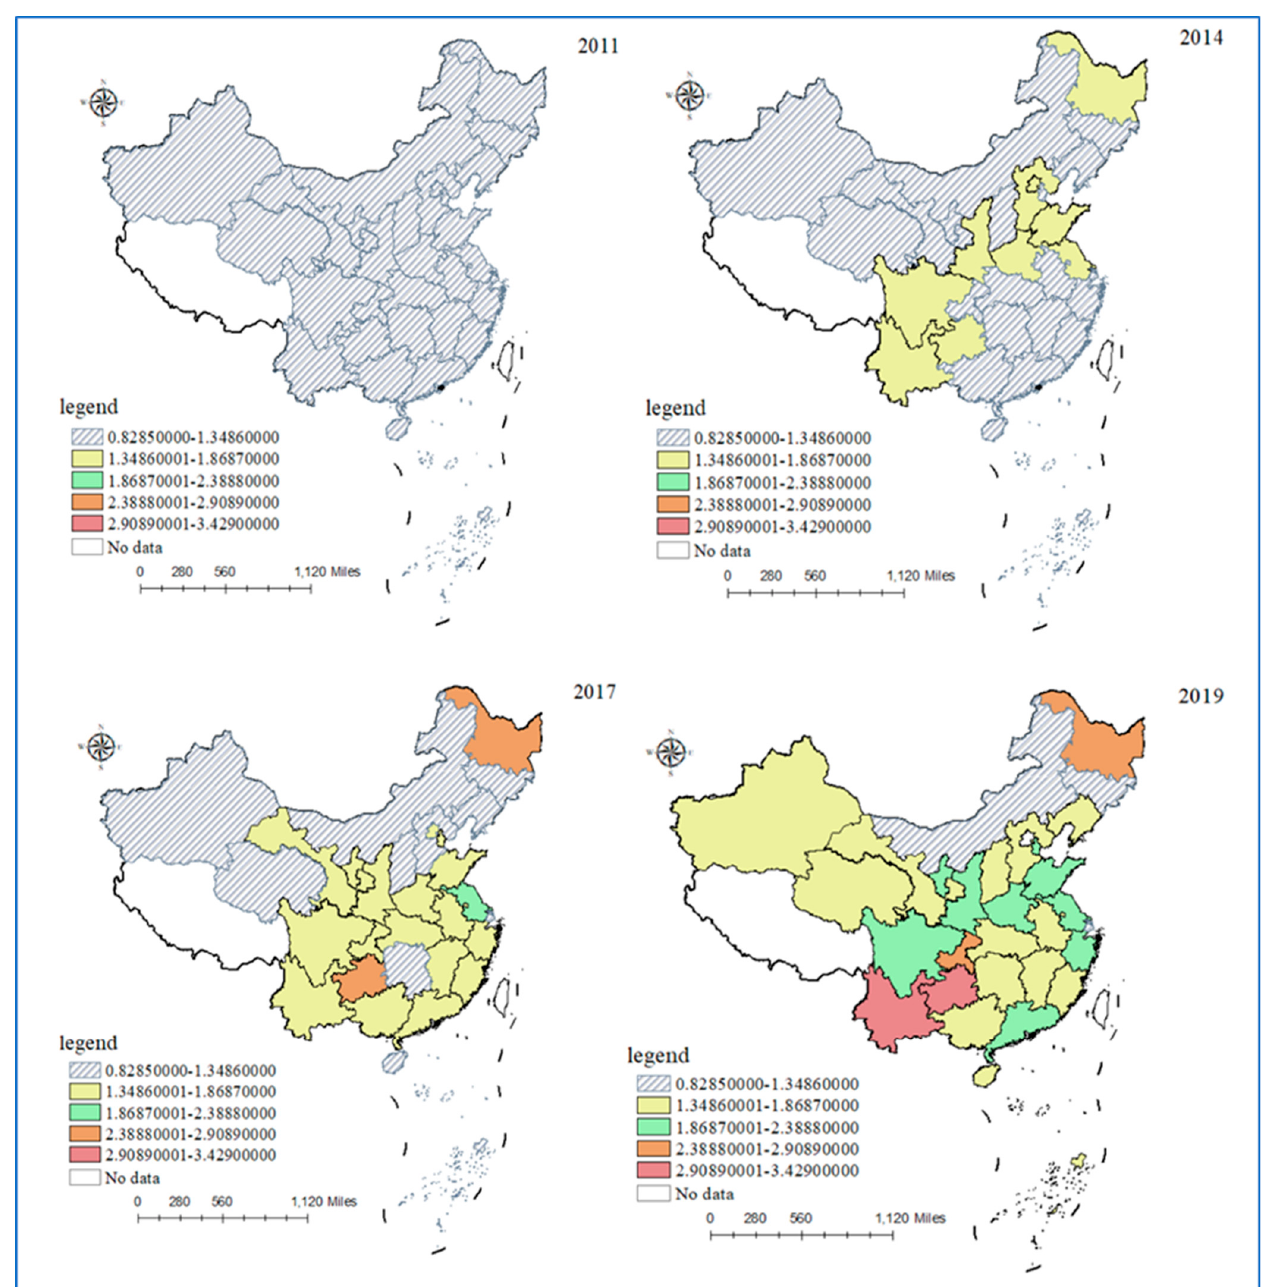
Figure 2. The spatial-temporal pattern of the ACP in China.